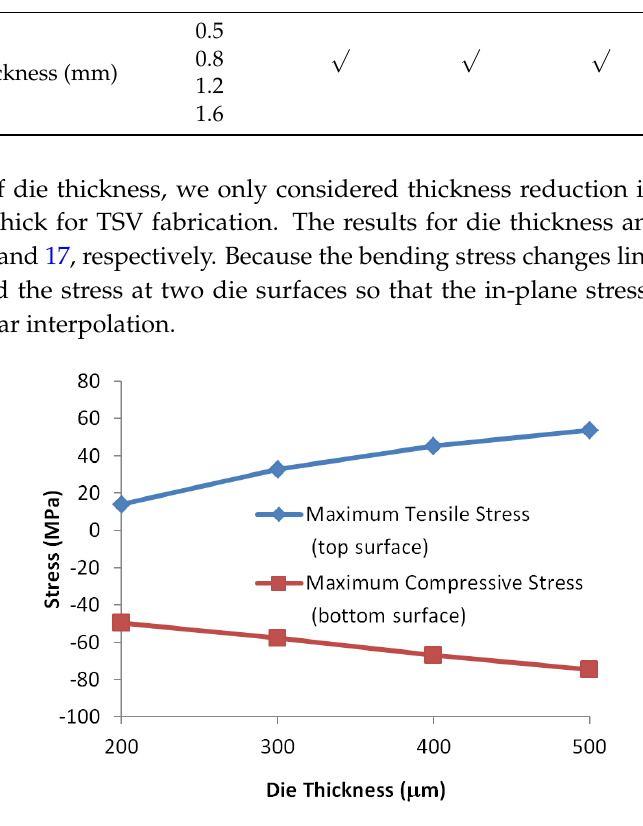
Table 3. Test matrix for studying the effect of die and PCB thickness.